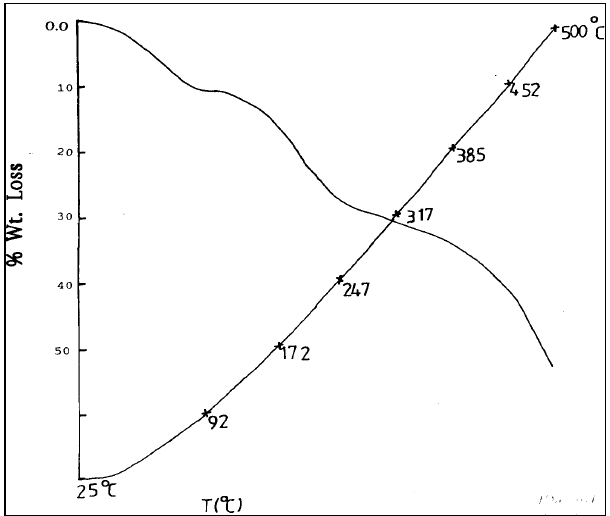
Figure 5. TGA of PAN prepared potentiostatically at 0.8 V. A heating rate of 10 o